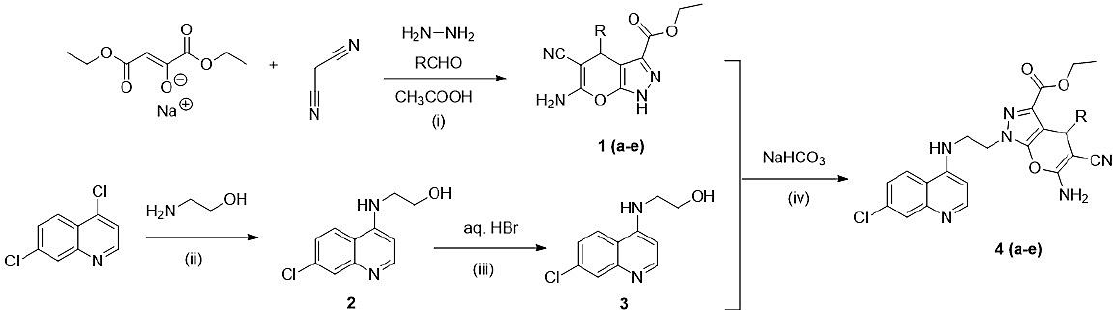
Figure 7. Reagents and conditions: (i) EtOH, reflux 1–2 h, R = benzaldehyde, 4 ‐ ethylbenzaldehyde, isobutyraldehyde, 4 ‐ hydroxybenzaldehyde and furaldehyde; (ii) reflux 1h; (iii) reflux 3 h and (iv) DMSO, r.t.